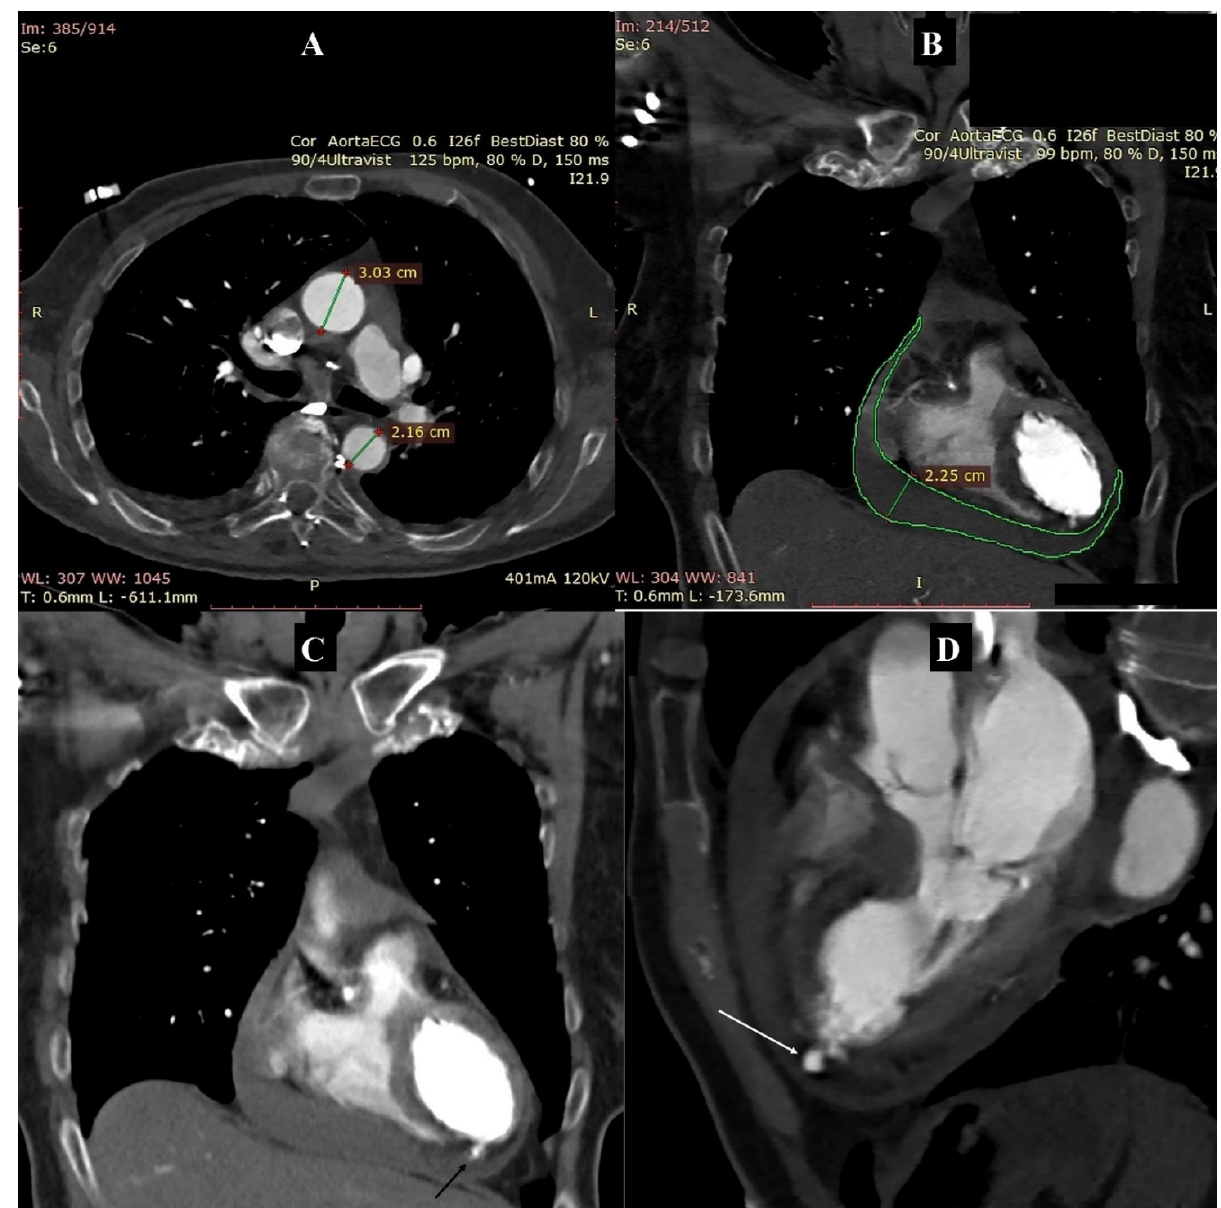
Figure 1. Computed tomography angiography of the thoracic aorta: ( A ) Axial reconstruction. Normal-sized thoracic aorta. Measurements: diameter of the ascending and descending aorta. ( B ) MPR reconstruction. Coronal view. Fluid in the pericardial sac. Contour: lamina of the pericardium. Measurement: maximum thickness of the fluid layer. ( C ) MIP reconstruction. Coronal view. Myocardial rupture with a visible active leakage of contrasted blood into the pericardial sac (arrow). ( D ) MPR reconstruction. Three-chamber view. Myocardial rupture with a visible active leakage of contrasted blood into the pericardial sac